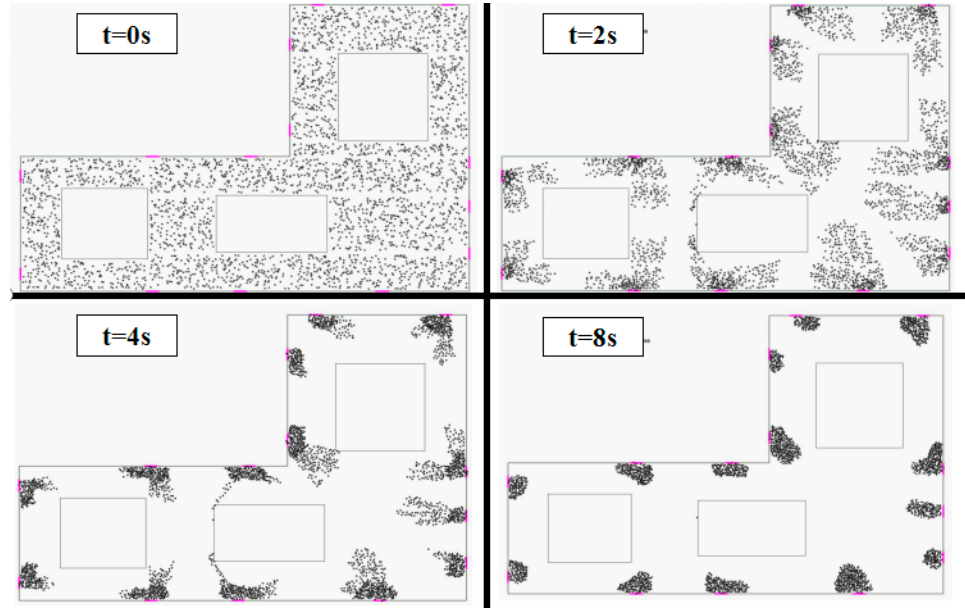
Figure 23. Screenshot of evacuation simulation of the exhibition center.